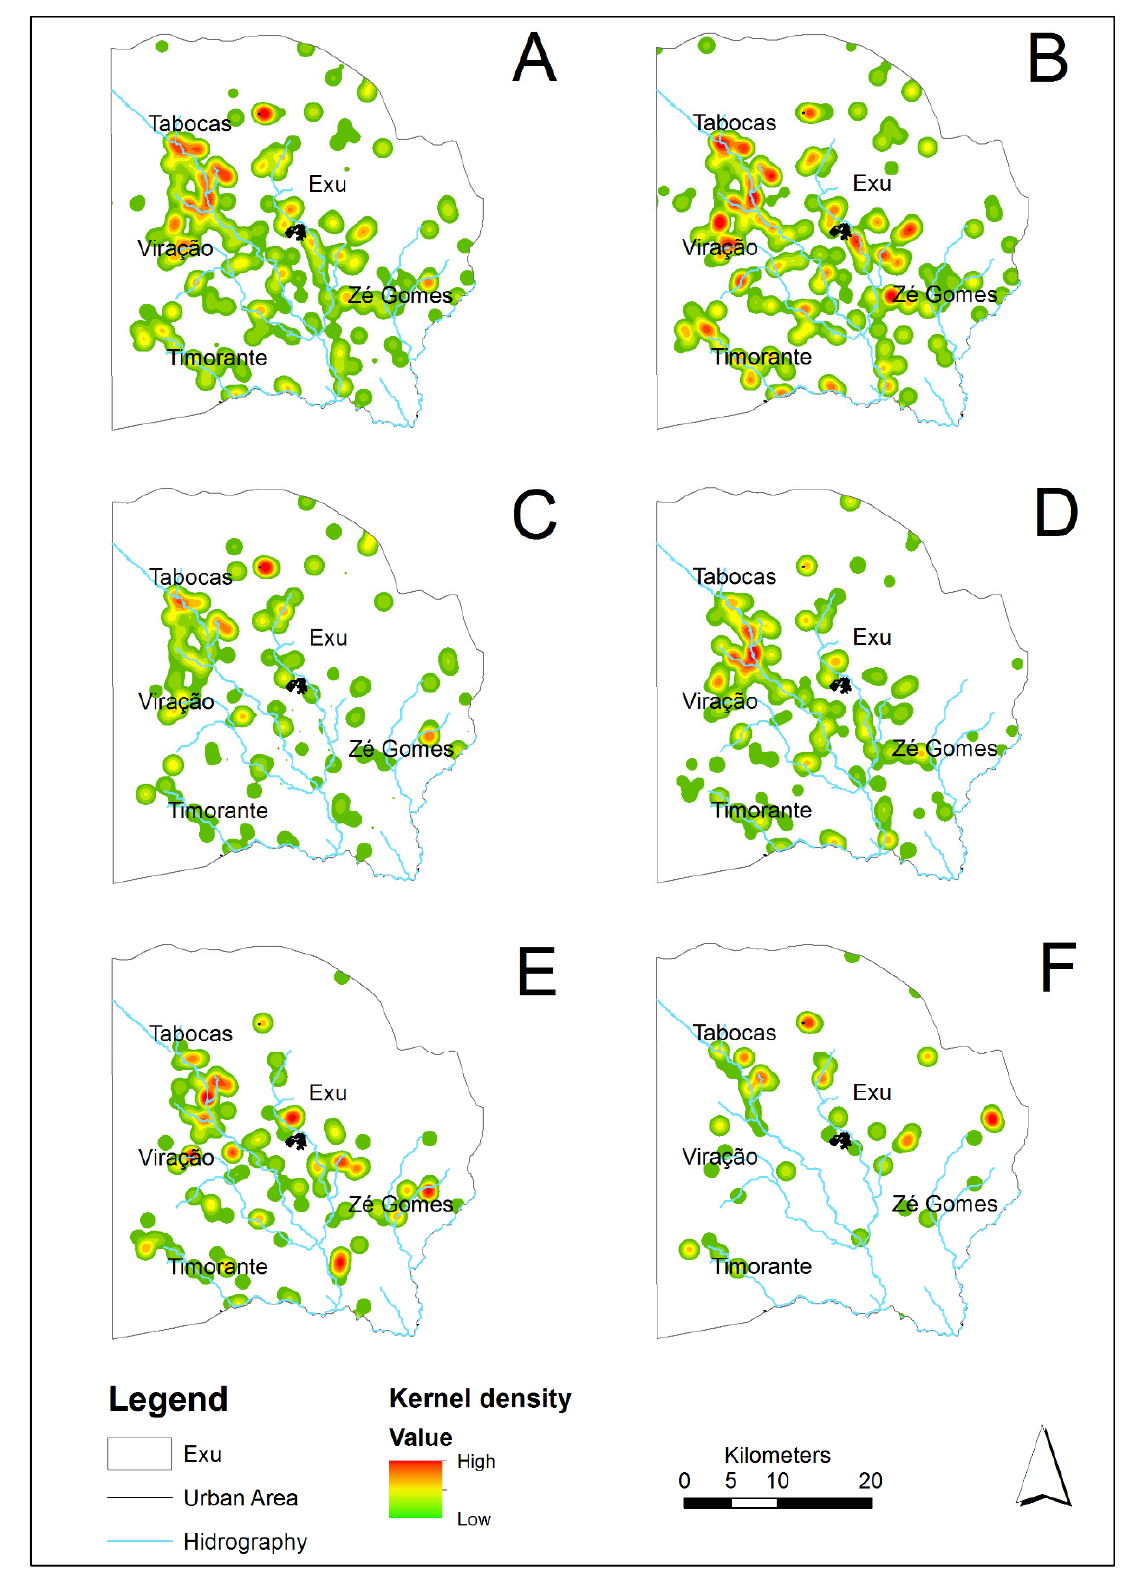
Figure 4. Risk maps for occurrence and density of rodent species based on the Kernel density estimator, in the localities of Exu, Pernambuco, Brazil, 1996 to 2005. ( A ) Total rodents captured. ( B ) R. rattus . ( C ) N. lasiurus . ( D ) Galea spixii . ( E ) T. laurentius . ( F ) C. langguthi .